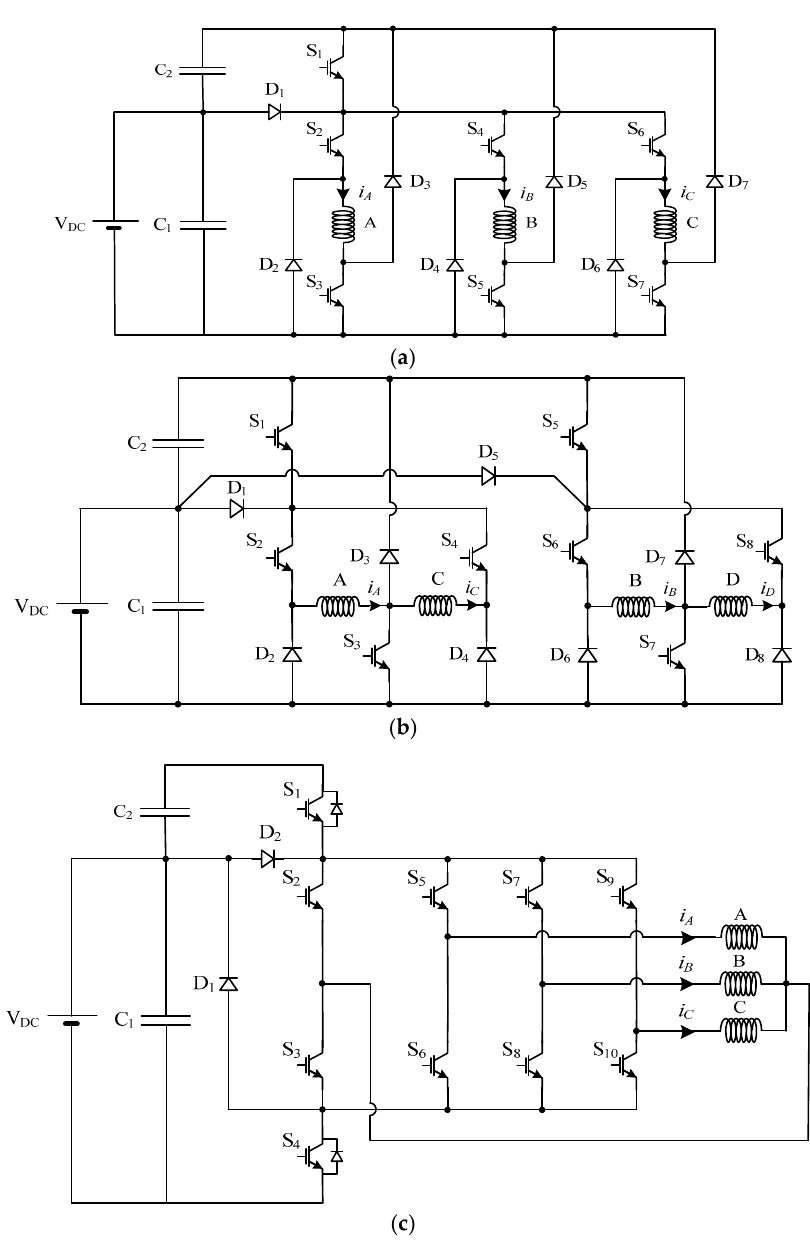
Figure 17. Multilevel converters based on an integrated boost circuit ( a ) with a classical AHBC ( b ) for 8/6 SRM with a common leg for two of the windings ( c ) with symmetrical legs and common point for the machine.